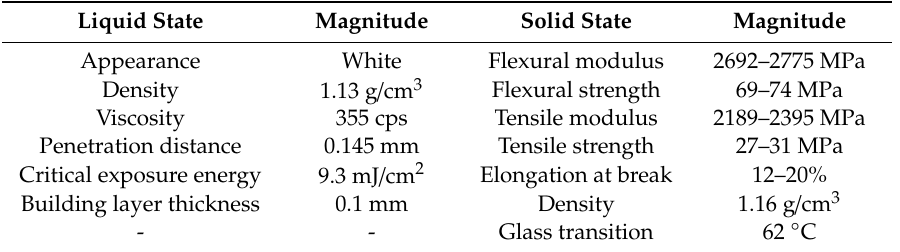
Table 1. Properties of the photosensitive resin at the liquid and solid states.